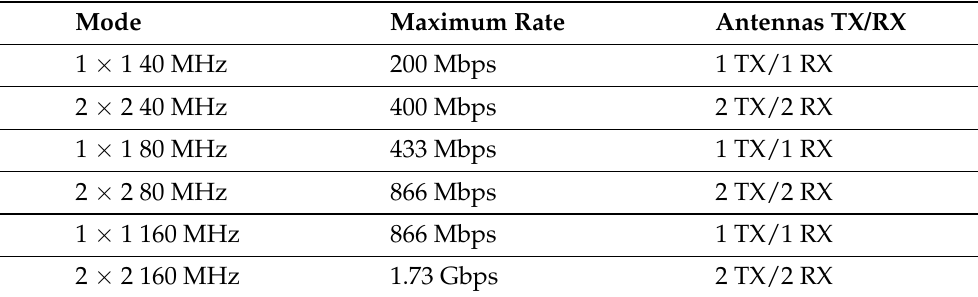
Table 2. Data rate on 802.11ac wave2